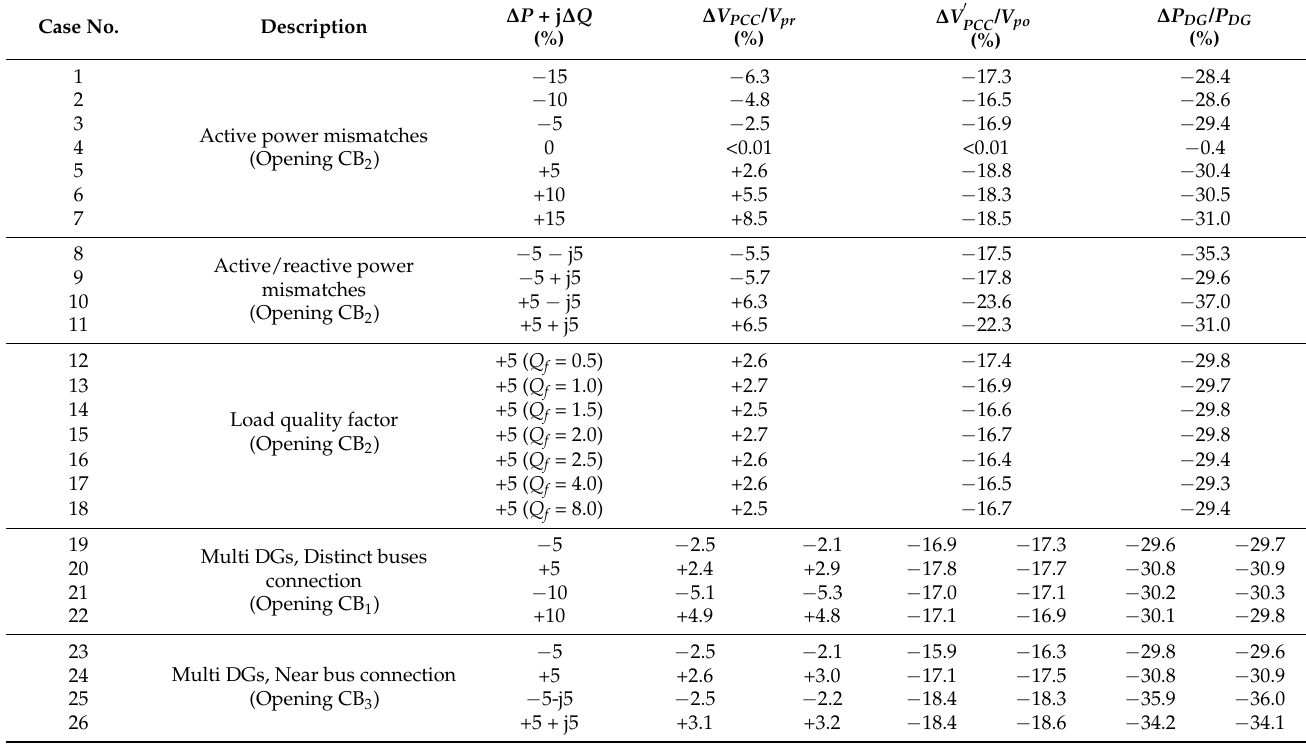
Table 2. Scenarios and outputs of the islanding cases.